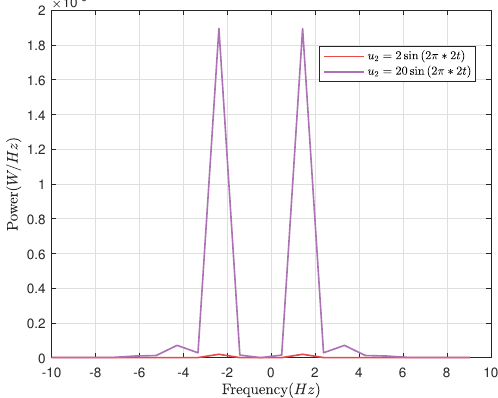
Figure 6. Power spectrum of the steady-state